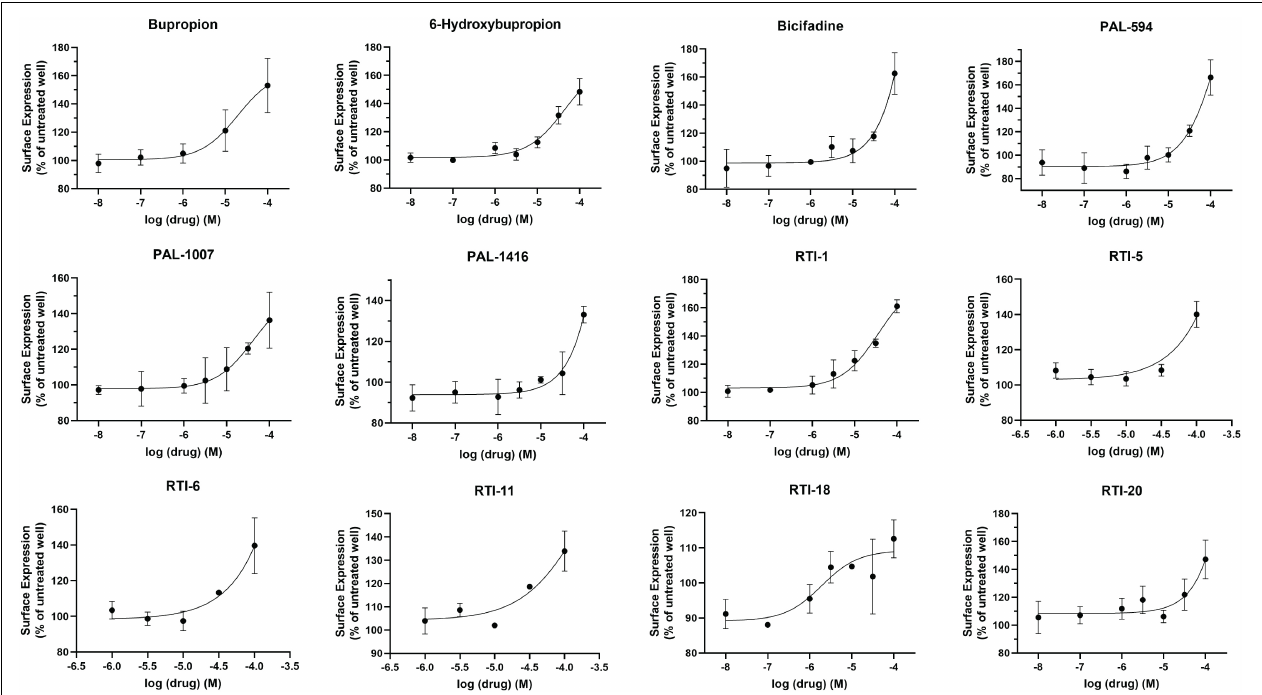
FIGURE 2 | Effect of overnight bupropion analog treatment on YFP-HA- β lac-DAT surface expression. Dose-dependent curves for most hit compounds of the bupropion backbone. Data were normalized to vehicle treatment. Data were fitted to one-site dose-response non-linear regression curves using GraphPad Prism. Data are means ± S.E.M. n =